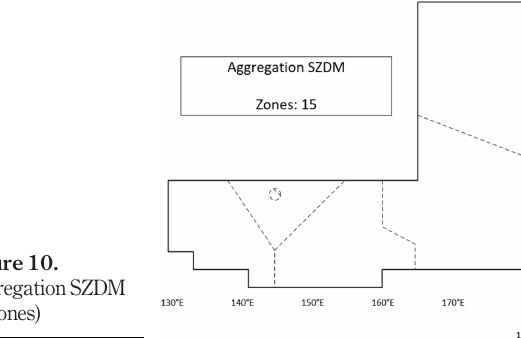
Figure 10. Aggregation